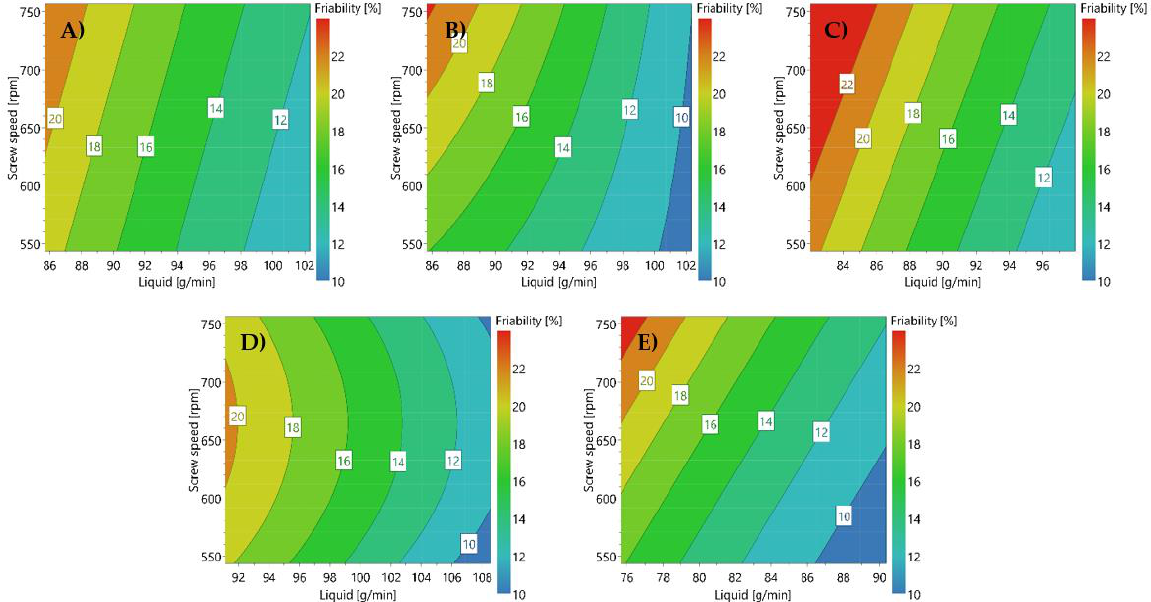
Figure 4. Friability contour plots of formulations containing 5% HPMC, lactose/MCC (1:1) as filler and ( A ) 5% acetaminophen, ( B ) placebo, ( C ) 5% theophylline anhydrous, ( D ) 10% mebendazole, and ( E ) 10% metformin hydrochloride. Adapted with permission from [12], Elsevier, 2020.